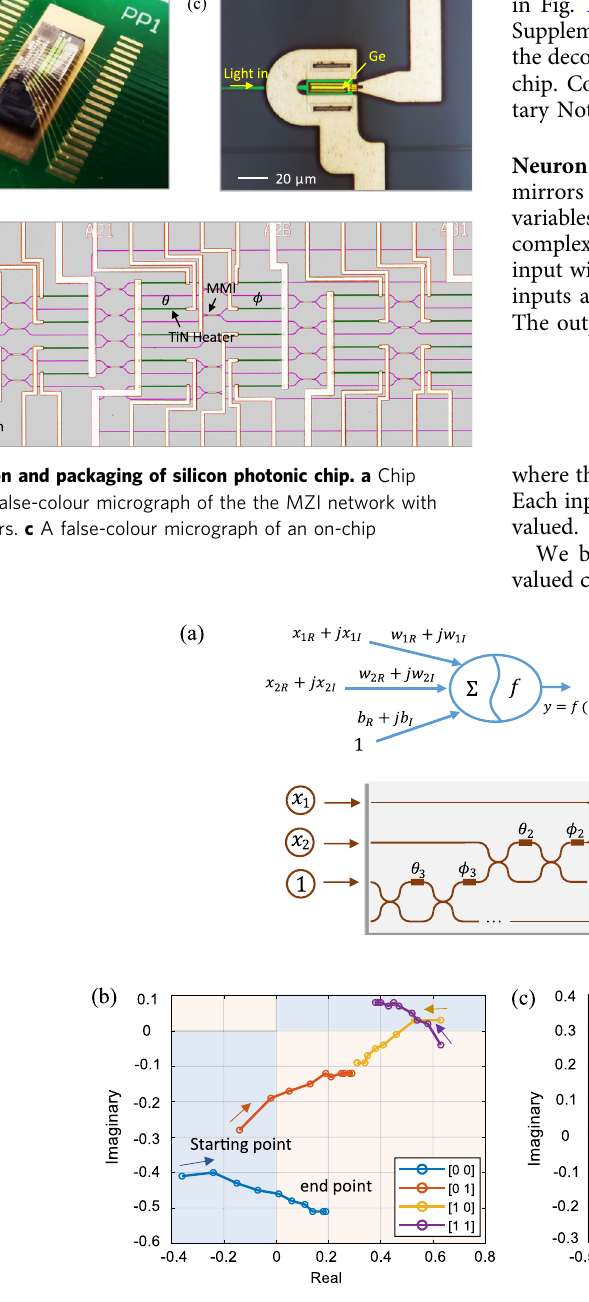
Fig. 3 A single complex-valued neuron for logic gate task. a The diagram of a complex-valued neuron and its on-chip implementation. The neuron output is the weighted sum of the input (e.g., x 1 R + jx 1I , where the footnote R/I represents the real and imaginary part, respectively) and complex weights (e.g., w 1R +